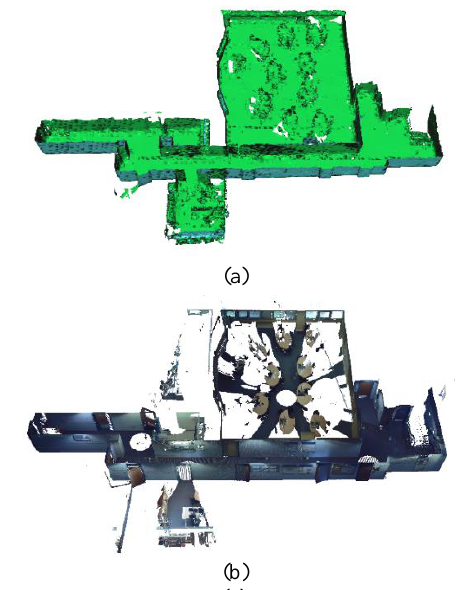
Figure 4. The acquired data: (a) the 3D mesh captured by the Hololens; (b) the registered point clouds captured by the terrestrial laser scanner. In both visualisations the ceiling is removed to give a better impression of the interior.